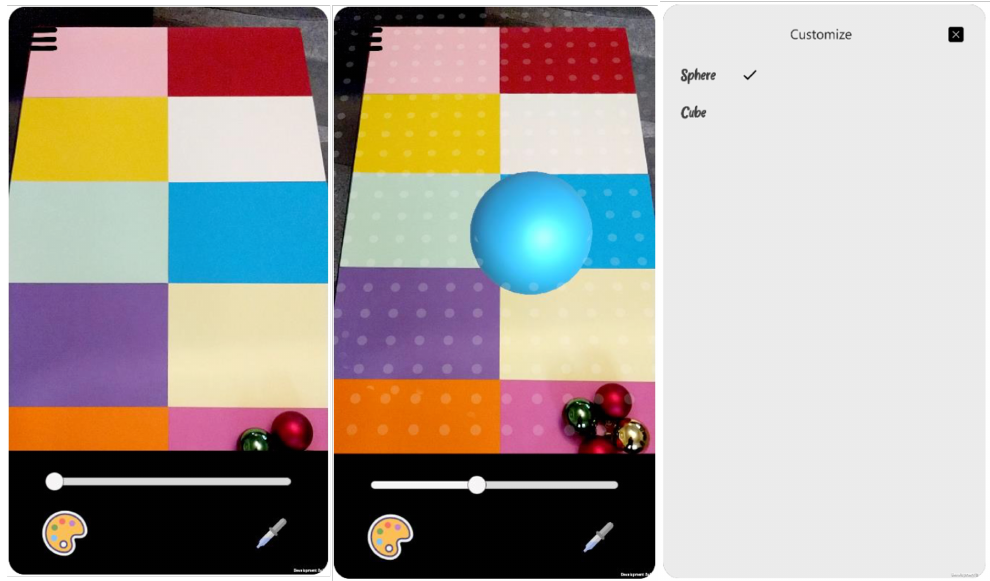
Figure 4. Variant B of the colAR